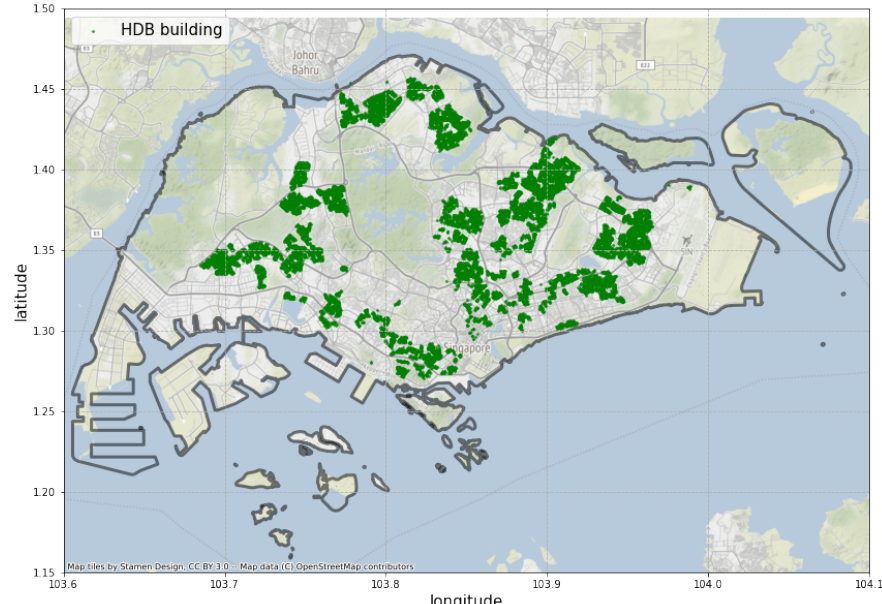
Figure 2. The distribution of HDB buildings in Singapore.